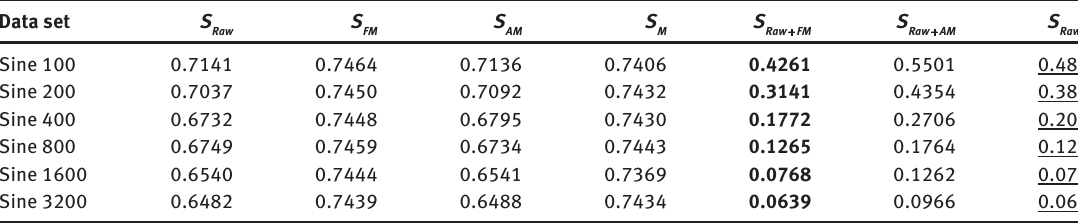
Table 5: SVM Misclassification Rates on the Six Non-overlapping Four-Class Synthetic Data Sets. Data set